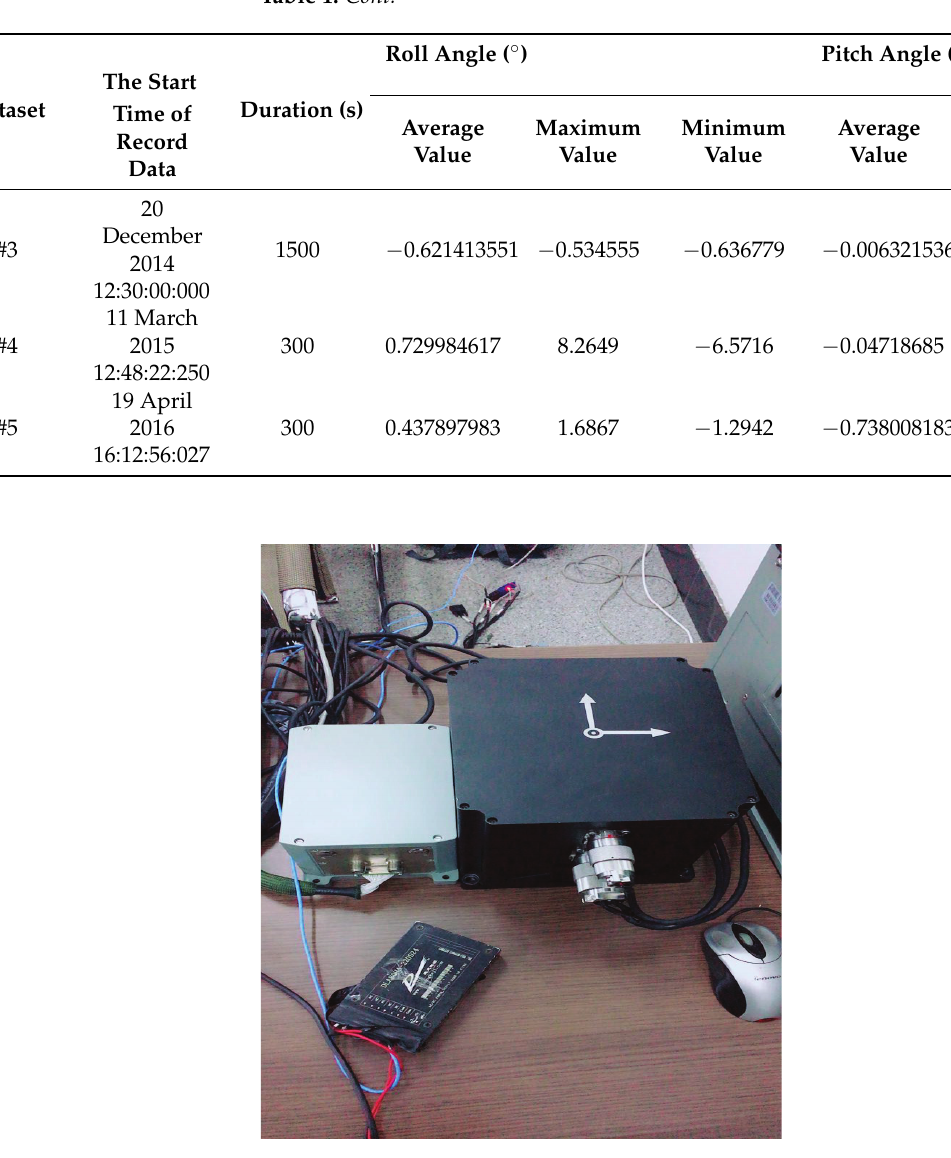
Figure 5. The scene of raw data acquisition.